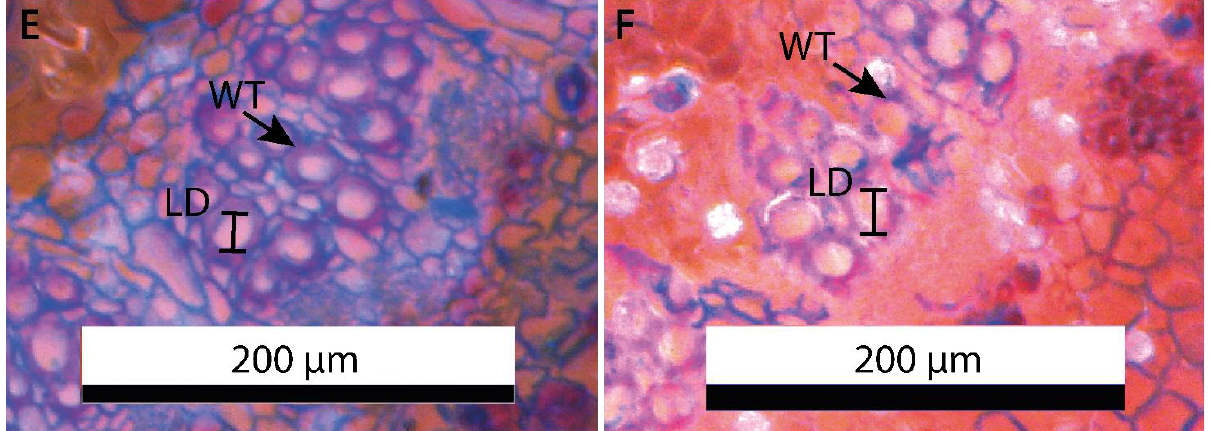
Figure 7. Histology cuts in the central vascular vein of the leaf in juveniles and adults of R. mangle . ( A ) SC + AD. ( B ) SC + JV. ( C ) SB + AD. ( D ) SB + JV. ( E ) OP + AD. ( F ) OP + JV. DL = Diameter of the lumen of the xylem vessels; WT = Thickness of the wall of the xylem vessels.